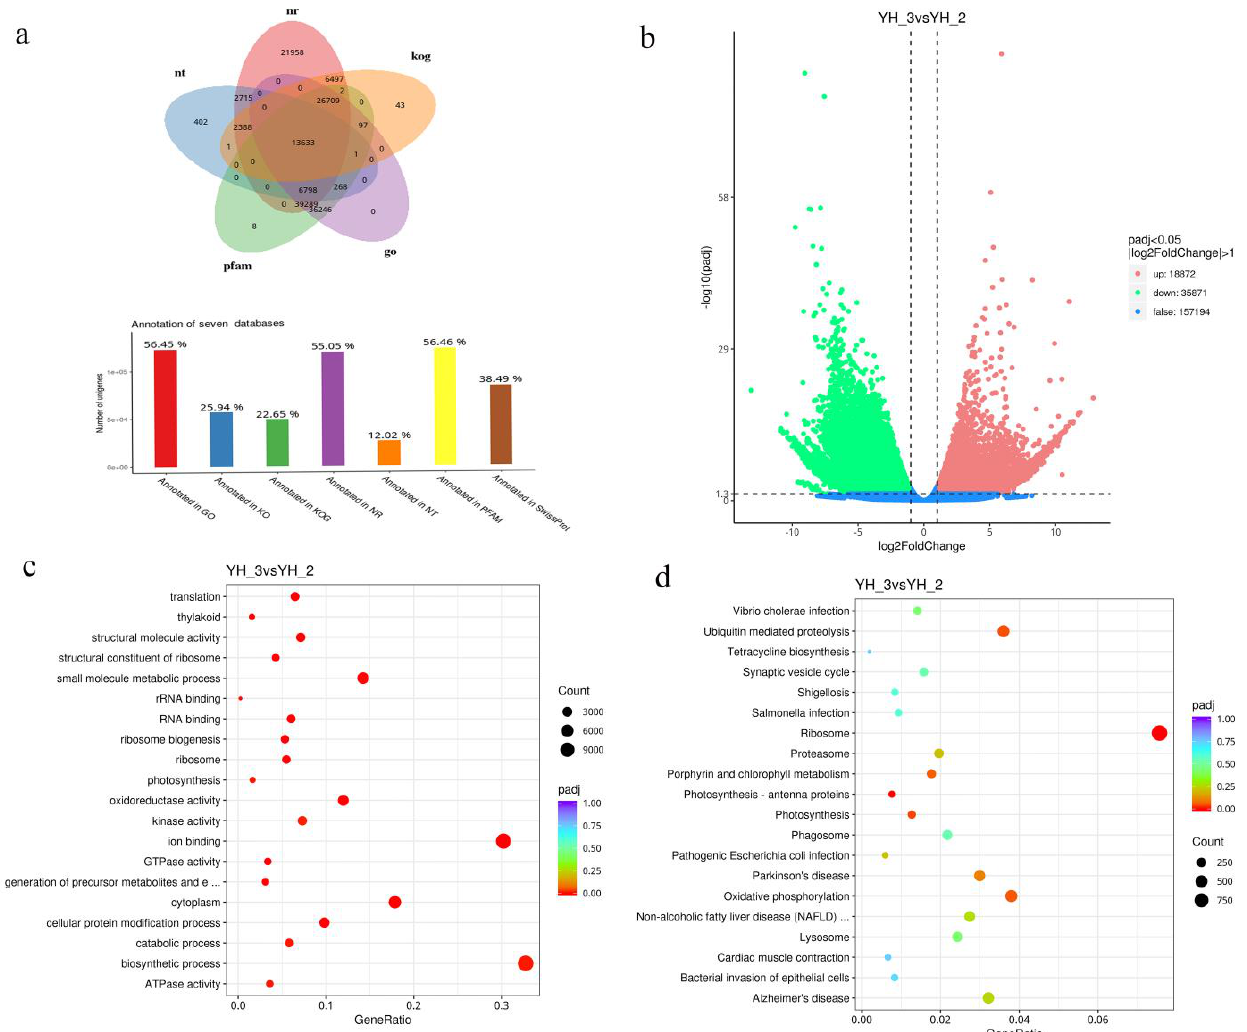
Figure 3. ( a ) Functional annotation numbers of unigenes in the NR, NT, KOG, PFAM and GO data- bases; ( b ) Number of DEGs; ( c ) GO classification; ( d ) KEGG enrichment of DEGs. Table 1. Statistics of sequencing data of all libraries.